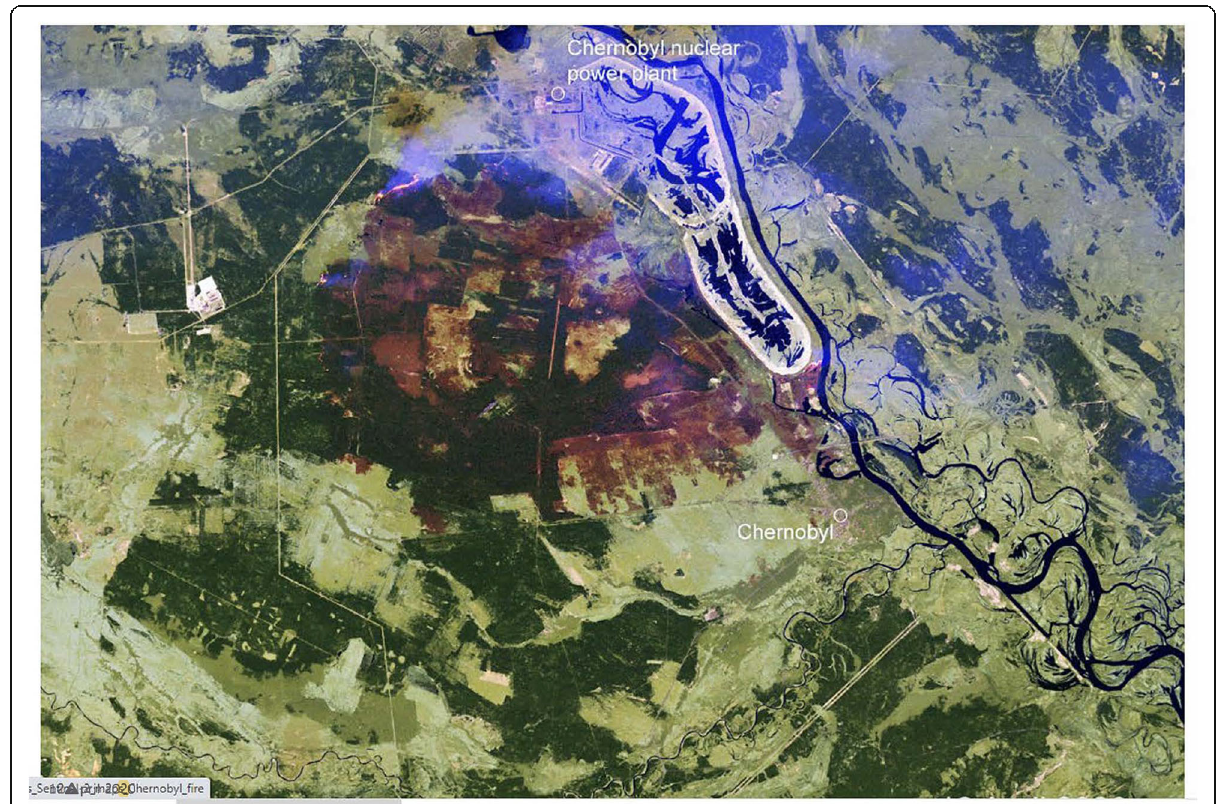
Fig. 9 Sentinel-2 image with few active fire fronts remaining from the 7 – 12 April, 2020, fire within the 30 km diameter Exclusion Zone around the Chernobyl reactor site that had a catastrophic meltdown in 1986. The 13 spectral bands from S-2 data were processed by ESA to show the smoke plumes and the bright active fire areas along the front edges of the burned area. Smoke plumes are easily observed in the visible bands while the enhanced radiance of the active fire area is easily detected in the SWIR region. The burned area is often imaged from a normalized burn ratio (the difference in reflecctance between NIR-SWIR divided by the sum NIR + SWIR). Figure is based on analysis of Copernicus Sentinel-2 data (12/04/2020), processed by ESA under Creative Commons Attribution-ShareAlike 3.0 IGO (CC BY-SA 3.0 IGO)